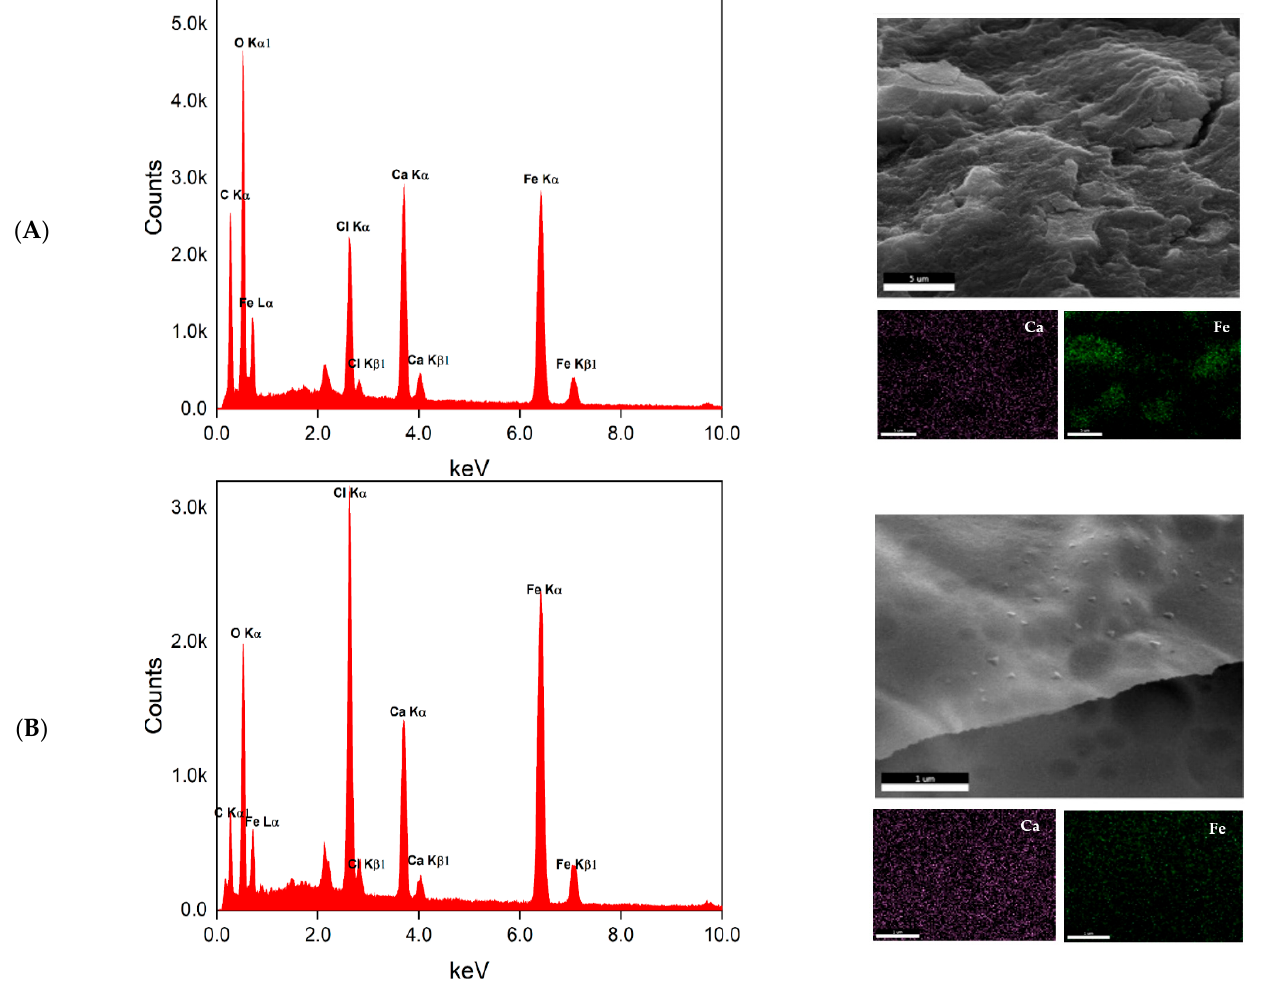
Figure 7. EDAX measurements and mapping for surface ( A ) and cross-section ( B ) of the 10G/Alg/FA/Fe 3 O 4 film.